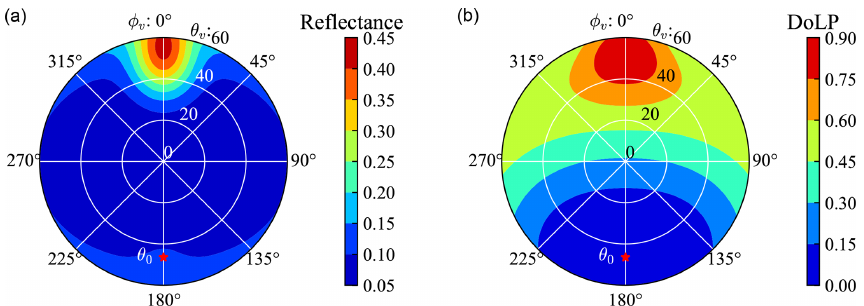
Figure 2. The reflectance (a) and DoLP (b) from radiative transfer simulation with the wind speed of 4.13ms − 1 , the aerosol optical depth of 0.26, Chl a of 0.05mgm − 3 , and ozone column density of 196DU. The antisolar point is indicated by the red asterisk with a solar zenith angle θ 0 = 46 . 41 ◦ . θ v and φ v indicate the viewing zenith and relative azimuth angles. The principal plane is defined by the viewing azimuth angle of 0 ◦ and 180 ◦ .